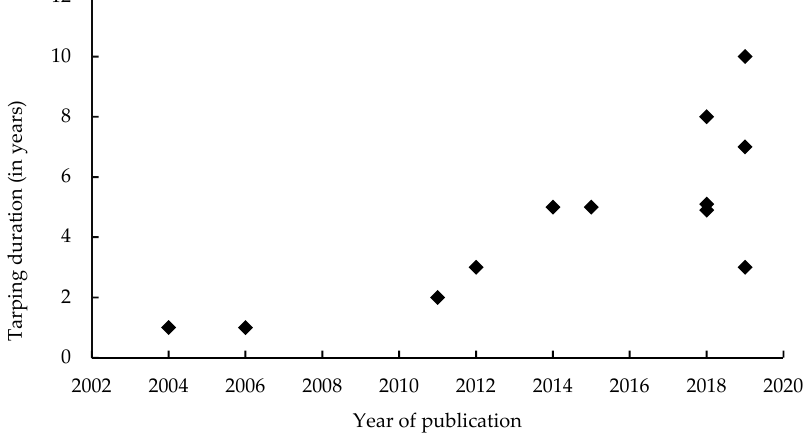
Figure 2. Changes in the recommended tarping duration according to the documents’ publication year.